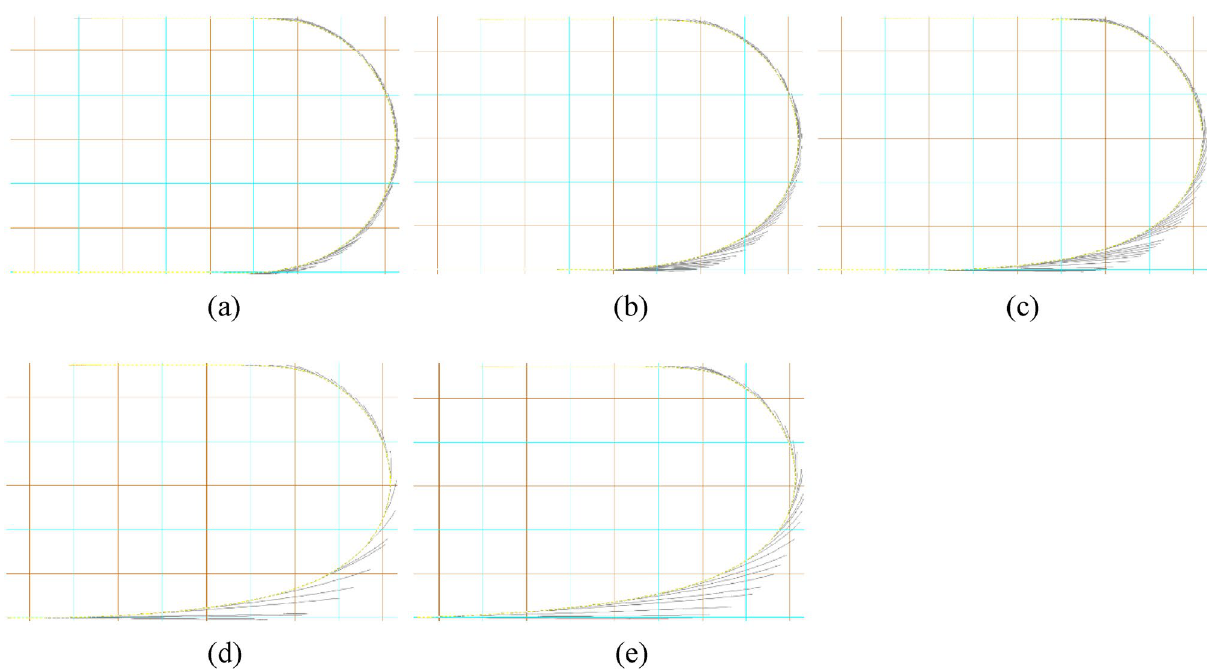
Figure 7. Configurations of marine cable at top view at different water depths during turning process: ( a ) 50 m; ( b ) 75 m; ( c ) 100 m; ( d ) 125 m; ( e ) 150